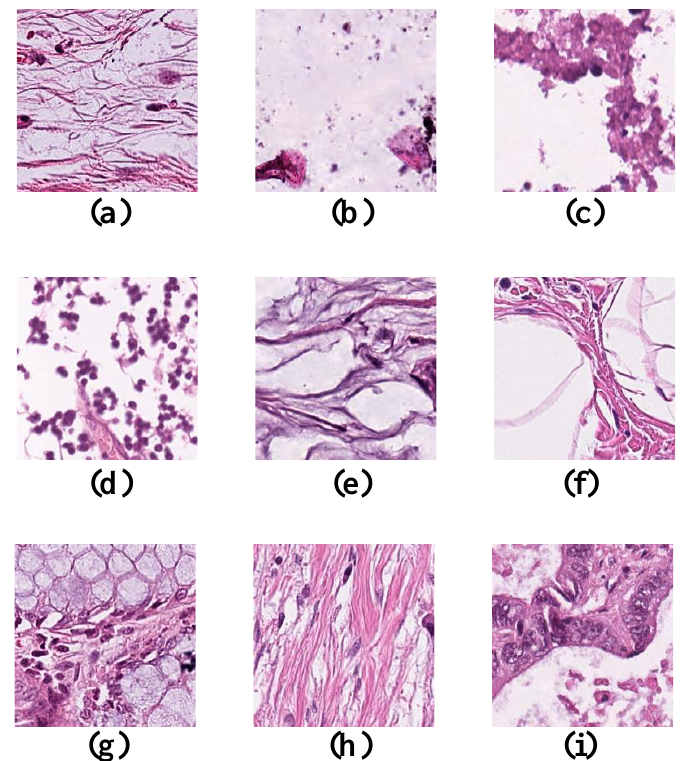
Figure 4. Example images of the nine tissue classes represented in the NCT-CRC-HE-100K dataset. ( a – i ) defined in Section 3.2.1.